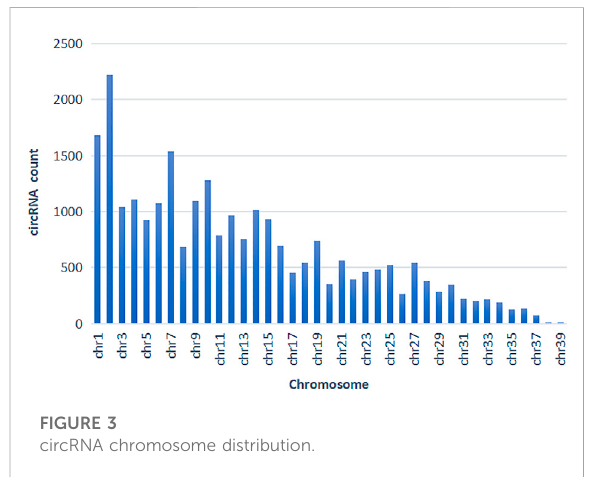
FIGURE 3 circRNA chromosome